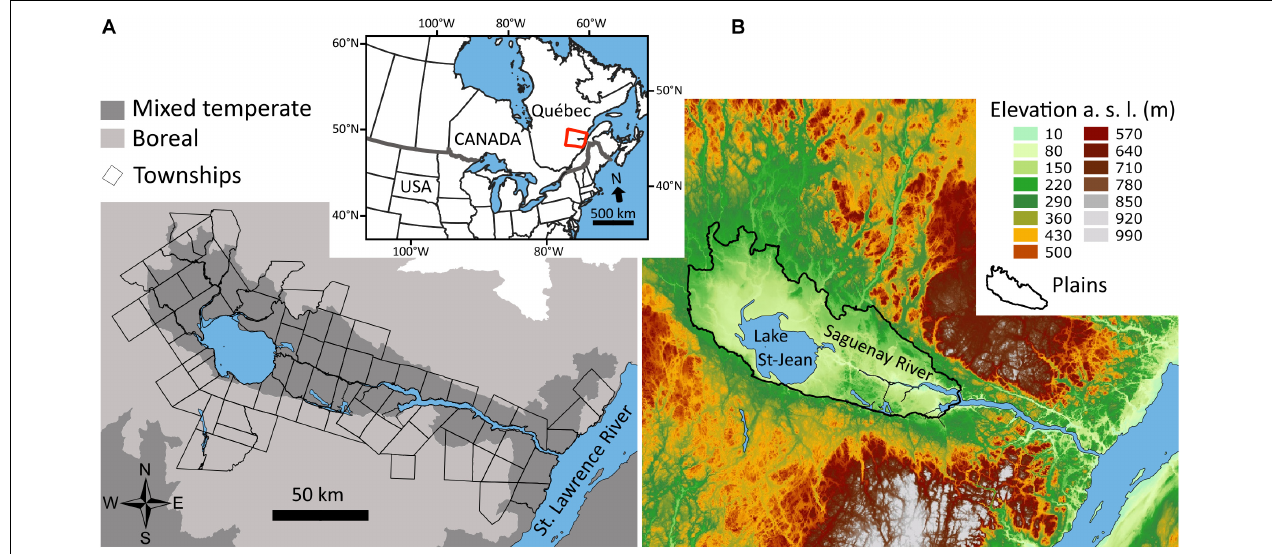
FIGURE 1 | Location of the study area (inset) in eastern Canada, along with maps of townships and vegetation zones (A) , and of the elevation bands (metres above sea level) showing the Saguenay-Lac-St-Jean Plains (B)